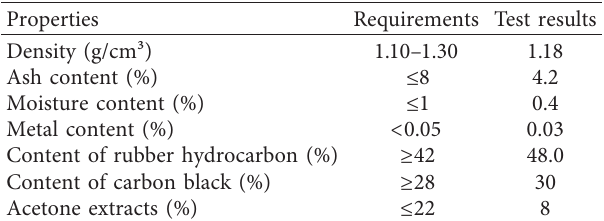
Table 2: Basic properties of crumb rubber modifier used herein